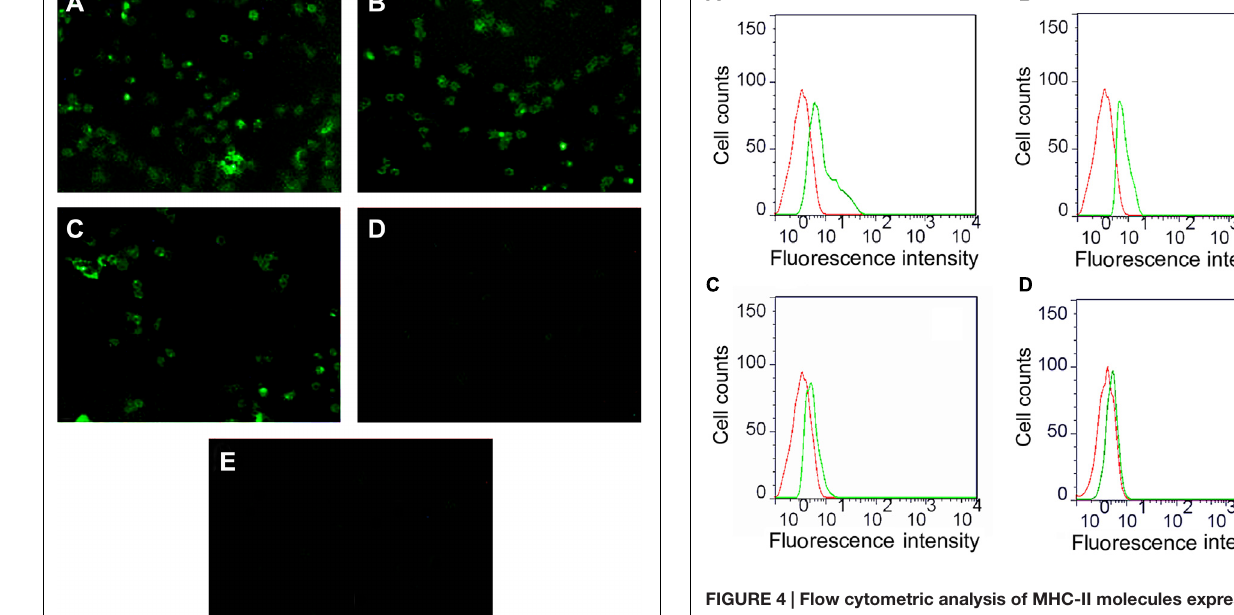
FIGURE 4 | Flow cytometric analysis of MHC-II molecules expressed on macrophages. The macrophages were cultured into 24-well cell culture plates and 5 µ g/mL ompA–Fc mixed with 50 µ g/mL TPPPS (A) , 5 µ g/mL ompA–Fc (B) , 5 µ g/mL ompA (C) , and 50 µ g/mL TPPPS, (D) and 400 µ L PBS were added into each well. After 6 h incubation, cells were incubated with 10 µ L of mouse anti-chicken MHC-II antibody for 30 min and then stained with 1:500 FITC-conjugated goat anti-mouse antibody for 30 min. The expression of MHC-II molecules on the surface of macrophages was detected by flow cytometry. Red dotted line: PBS-treated macrophages (control group); green dotted line: recombinant protein and/or TPPPS-treated macrophages (experimental group). The images are representative of three independent